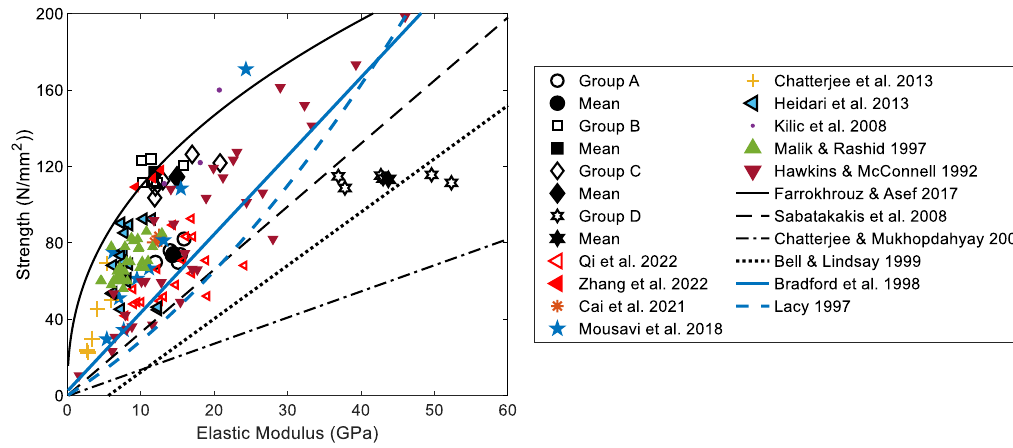
Figure 13. UCS and elastic modulus.